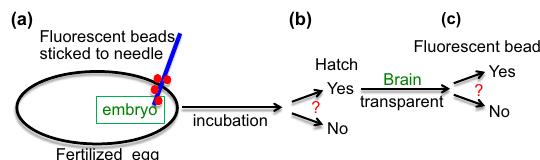
Fig. 4 The aim of this study. ( a ) Fluorescent beads mimicking micro-probes were inoculated into the future brain region of chick embryos. ( b ) After incubating the manipulated eggs, we examined whether they would hatch. ( c ) Upon hatching, the whole brain was removed from the skull. The brains were treated with transparent reagent and examined for fluorescent